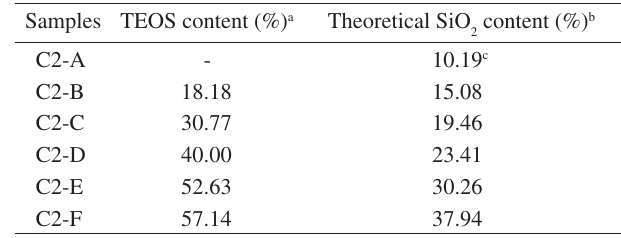
Table 2. Inorganic content in PU-2 after reaction with TEOS (C2) and theo- retical values of